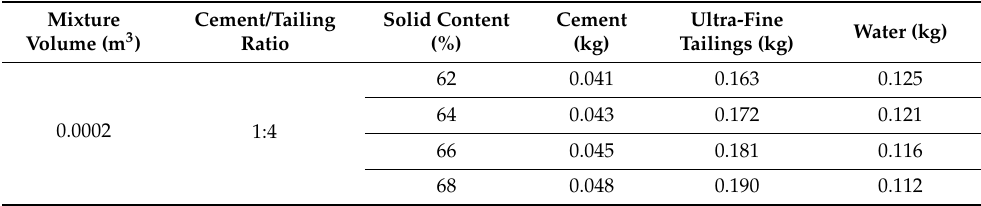
Table 3. The UCPB mix proportions for rheological tests.